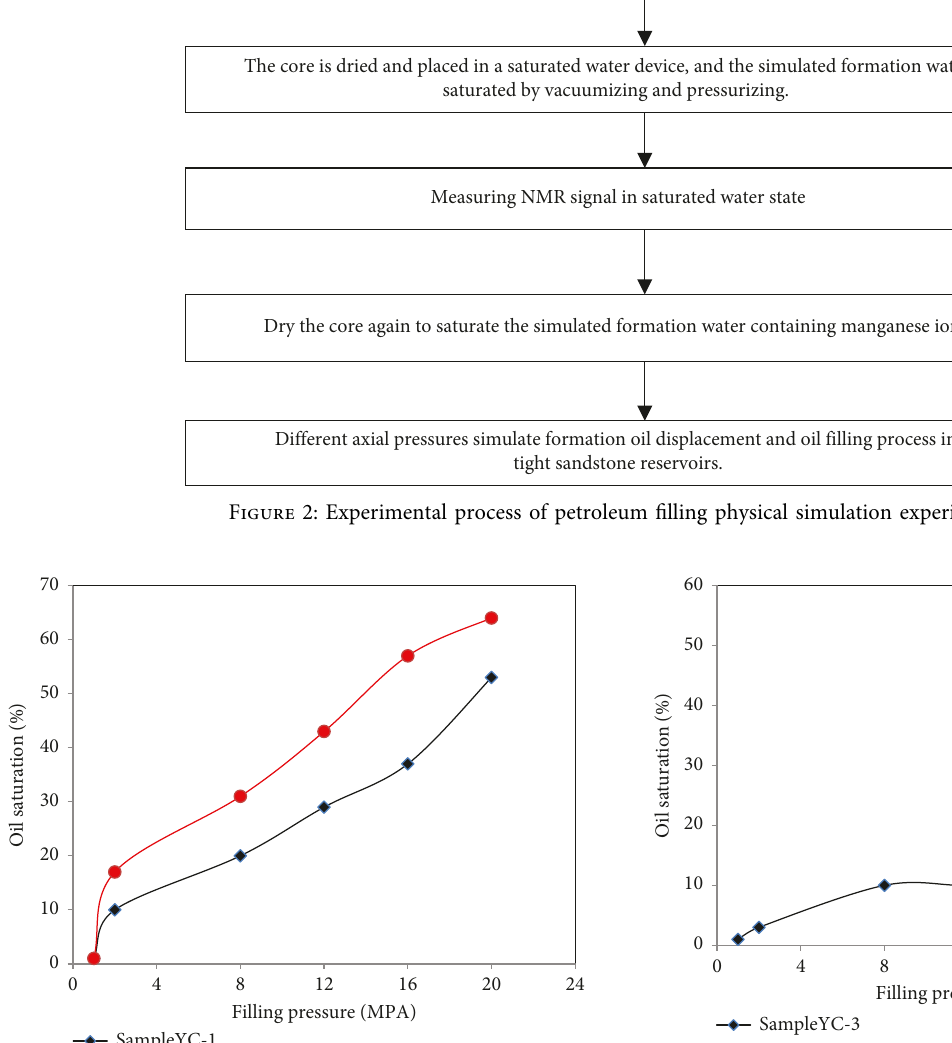
Figure 4: The relationship between filling pressure and oil satu- ration is gradually increasing-tending to be